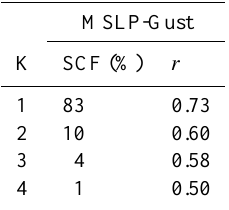
Squared covariance fraction, SCF, and temporal correlation coefficient, r , for the first modes of SVD analysis corresponding to the pairs of coupled